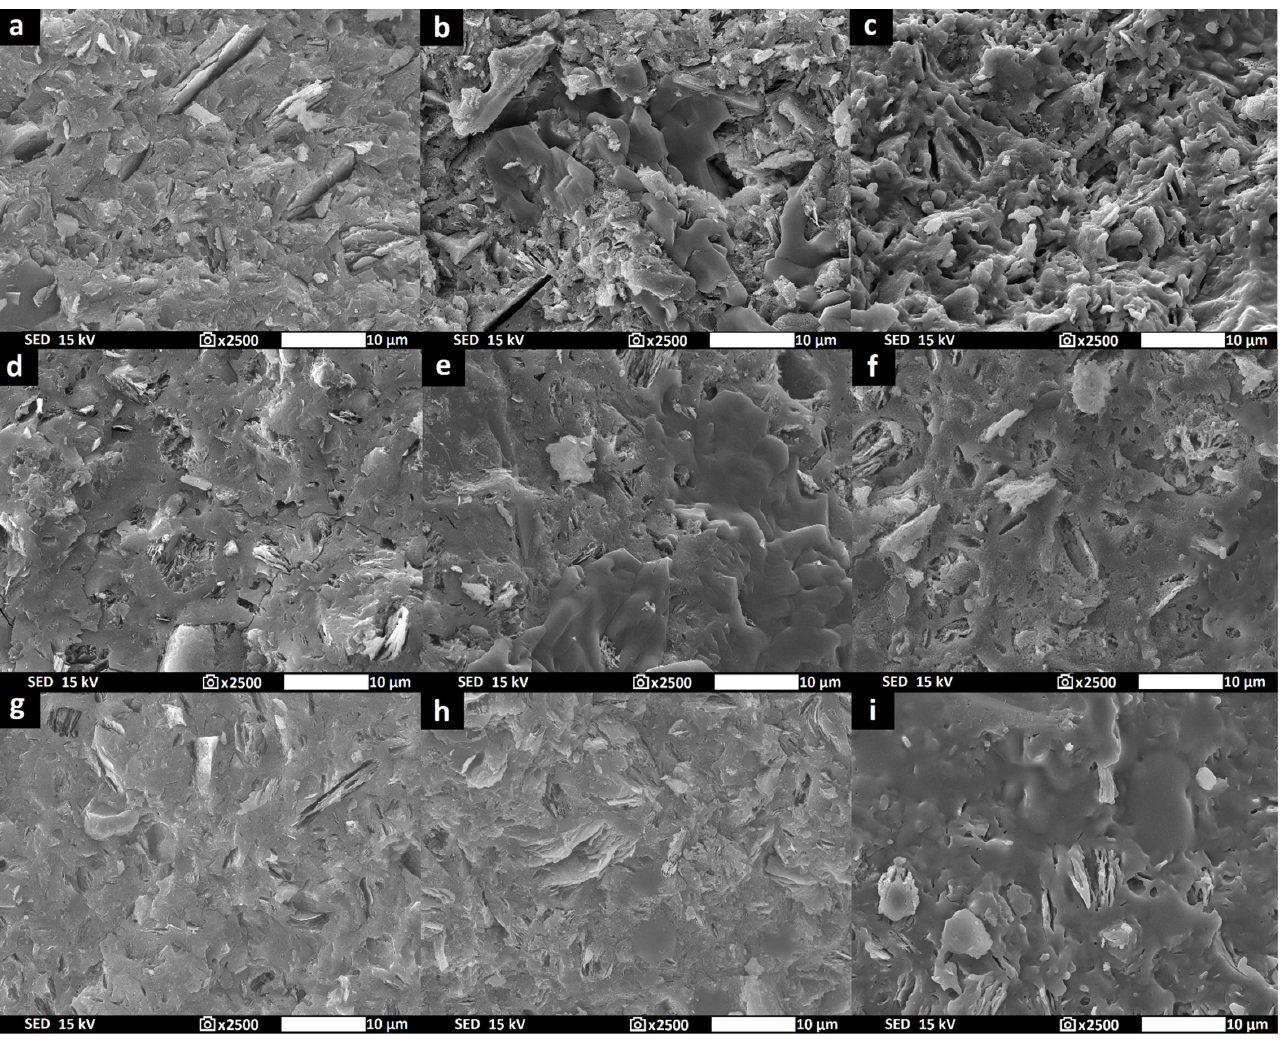
Figure 5. Micrographs of geopolymer binders with different type of aluminosilicate at